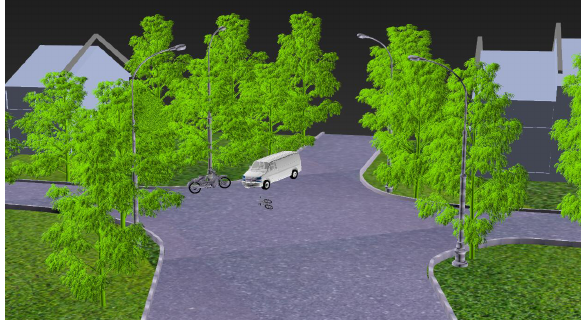
Figure 9. The construction of the overall 3D model of the traffic accident